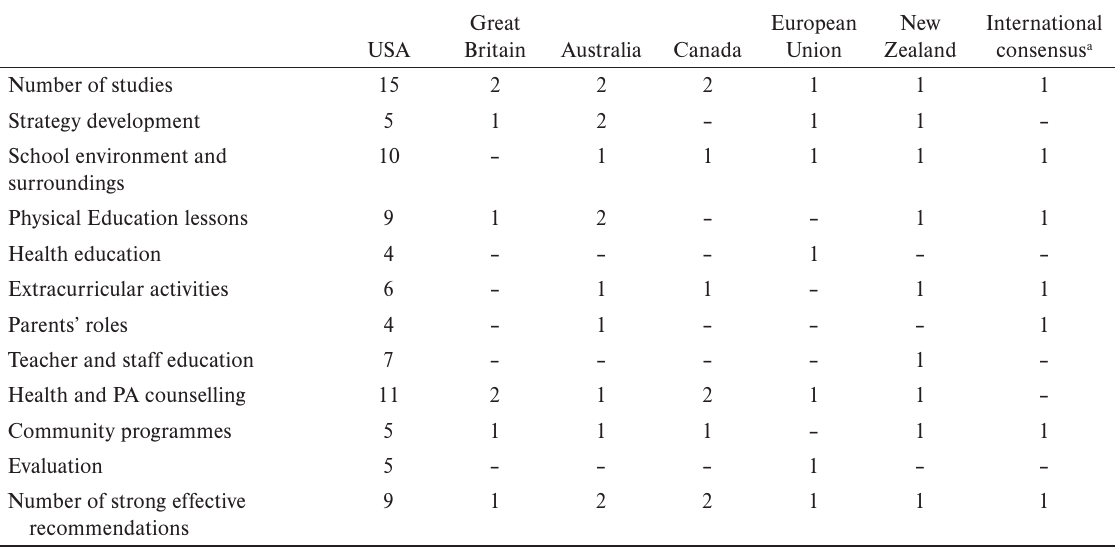
General characteristic of the included studies, organized by frequency and strength of